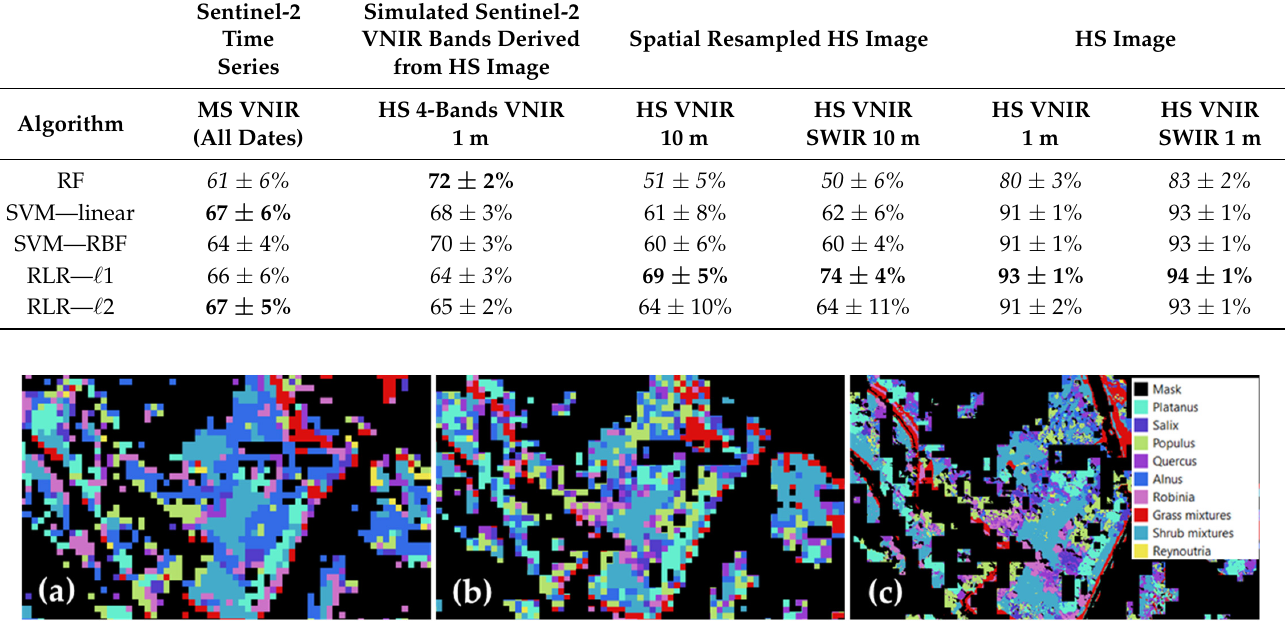
Figure 15. Subset of RLR-ℓ1 classification map without the rejection class obtained with ( a ) MS VNIR, ( b ) HS VNIR 10 m, and ( c ) HS VNIR 1 m. ( b ) HS VNIR 10 m, and ( c ) HS VNIR 1